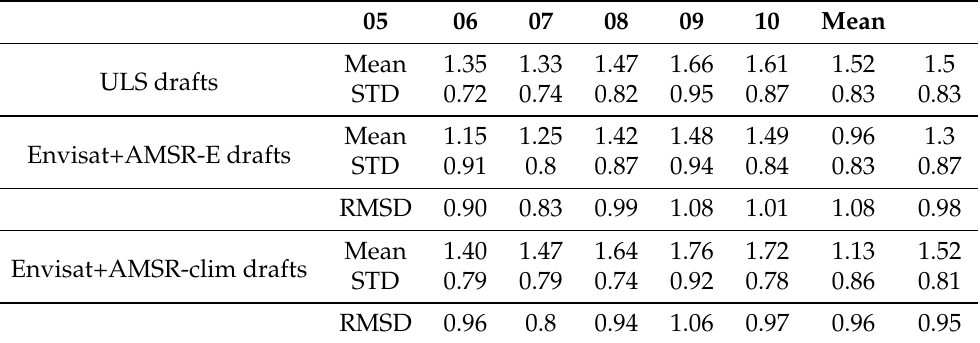
Table 3. Comparison between climatological monthly mean ULS and Envisat drafts computed over 2003–2011. Envisat drafts are computed from the AMSR-E and AMSR-clim snow depths. For each month (05 to 10), we also indicate the climatological standard deviation (STD) and the Root Mean square Deviation (RMSD) with ULS drafts.